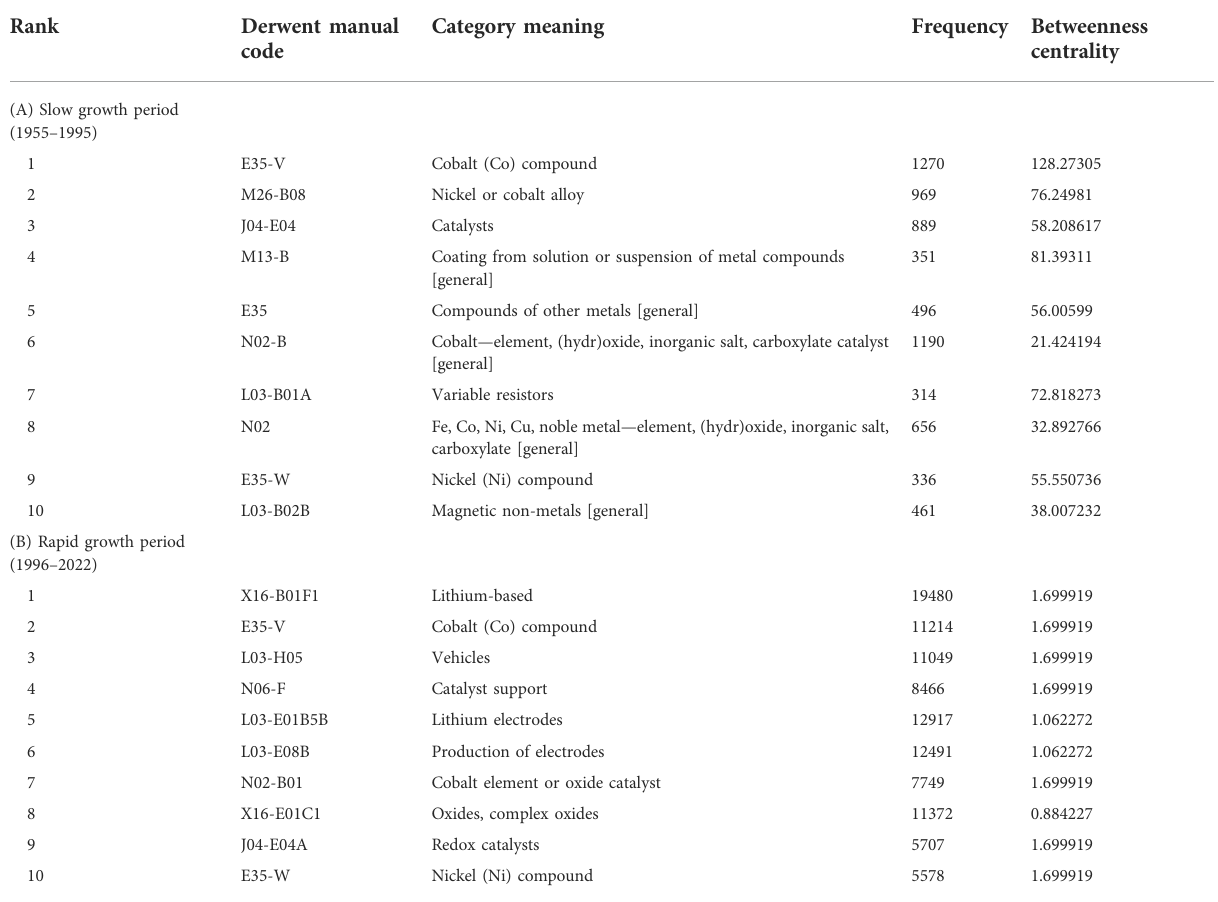
TABLE 1 Top 10 key technologies for cobalt.